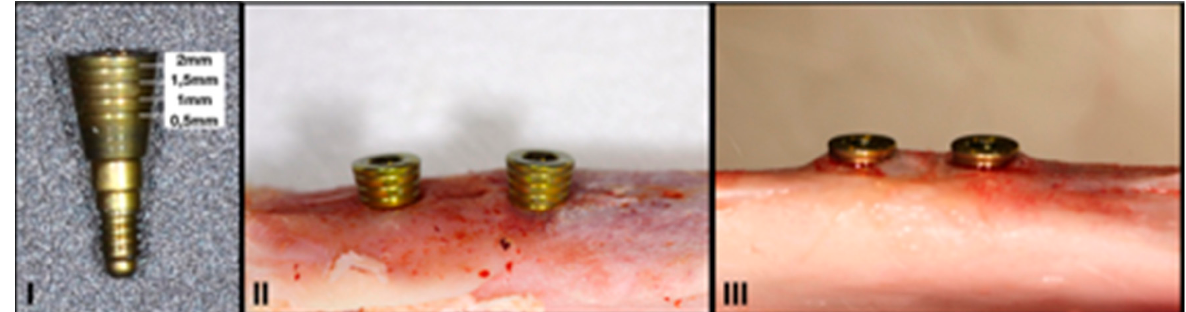
Figure 2. ( I ) Photo of one of the healing caps that allow for the quantification of the bone growth above the implant platform. ( II ) Image of two implants of the test group (Group A) following euthanasia. ( III ) Image of two implants of the control group (Group B) following euthanasia. It is possible to observe the differences between the heights of bone growth in the two groups.